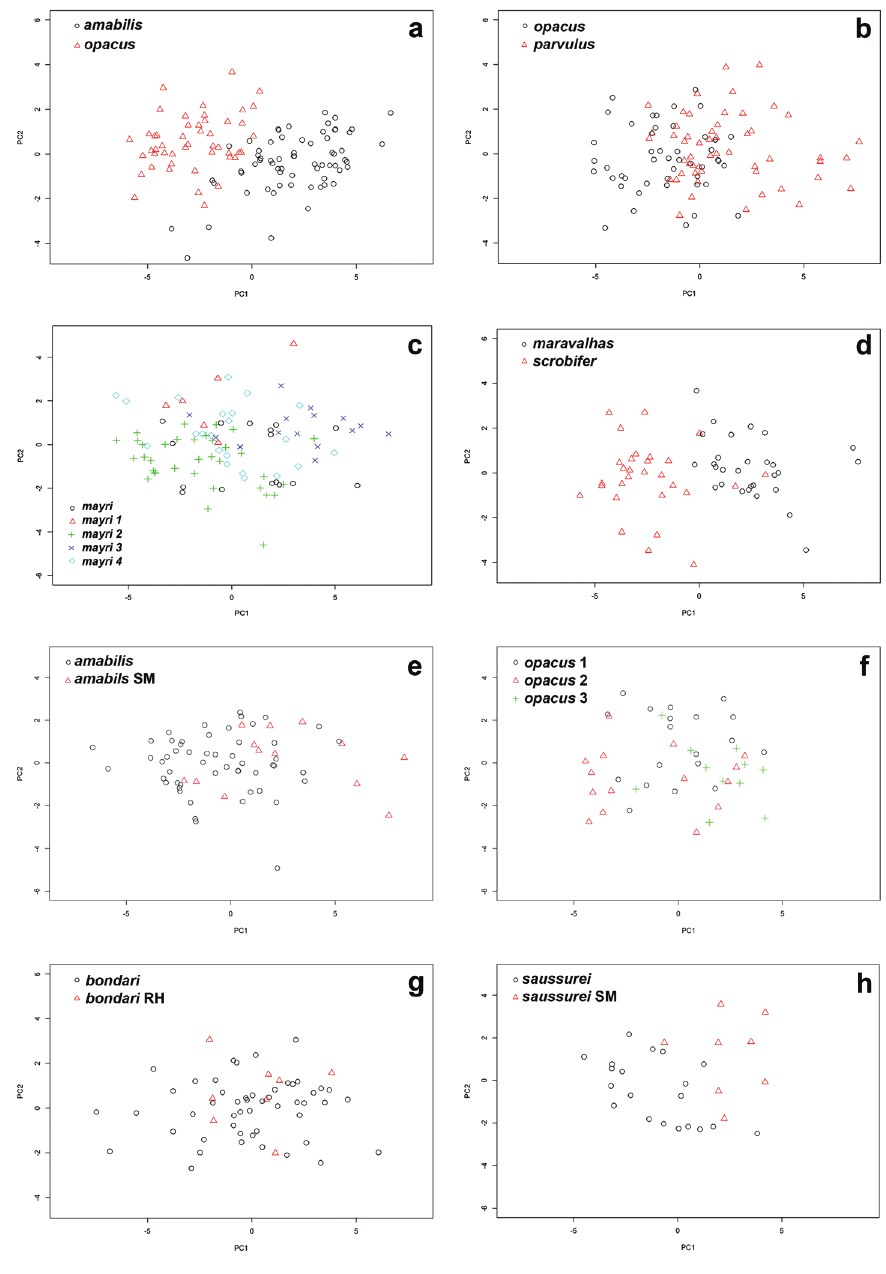
Figure 5. Principal component analysis of reduced data sets, scatter plots. a S. amabilis and S. opacus b S. opacus and S. parvulus c populations of S. mayri d S . maravalhas and S. scrobifer e populations of striate-mandibled S. amabilis vs. smooth-mandibled (SM) S. amabilis f populations of S. opacus g popula- tions of typical S. bondari vs. reduced-hair (RH) S. bondari h populations striate-mandibled S. saussurei vs. smooth-mandibled (SM) S. saussurei